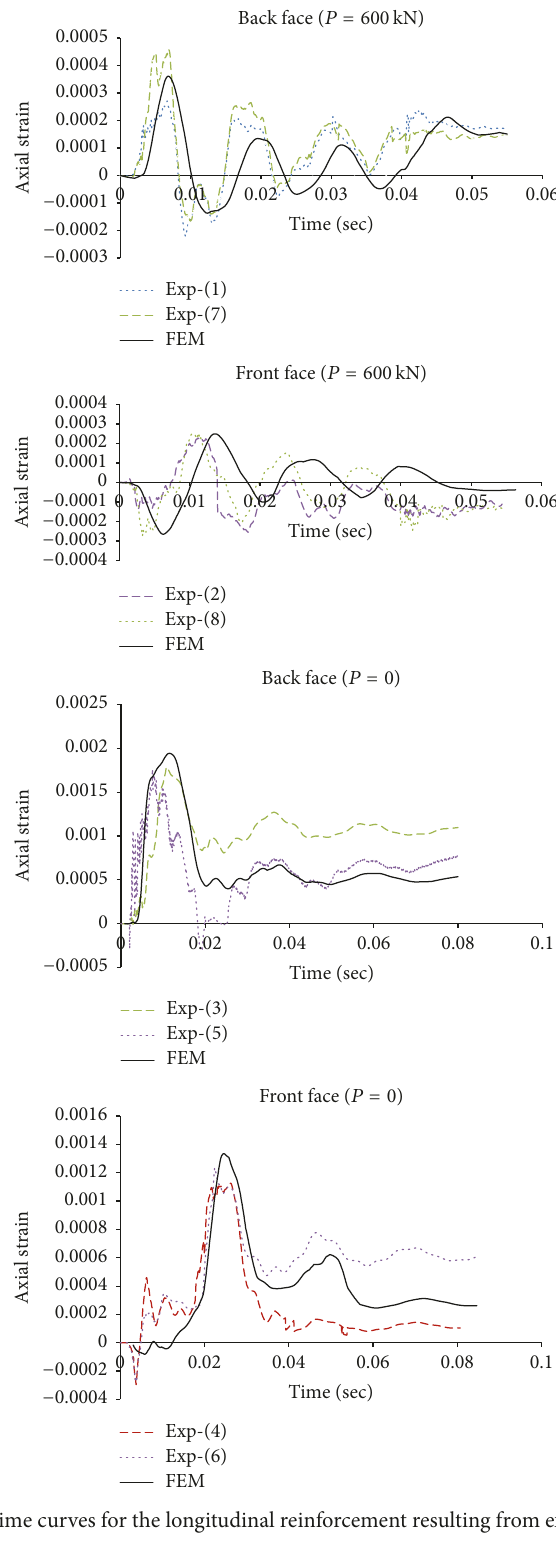
Figure 10: Axial strain-time curves for the longitudinal reinforcement resulting from experimental test and